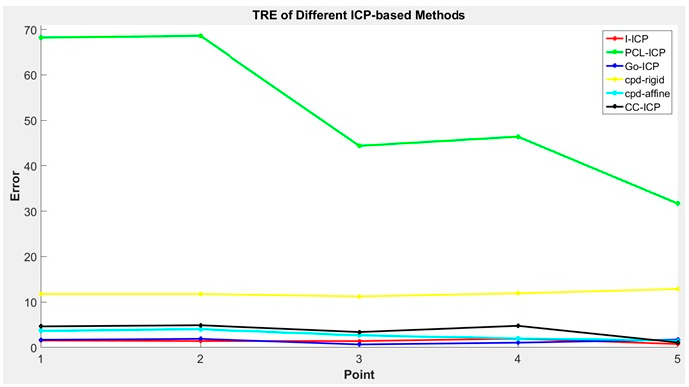
Figure 8. Compare the TRE of different ICP methods.